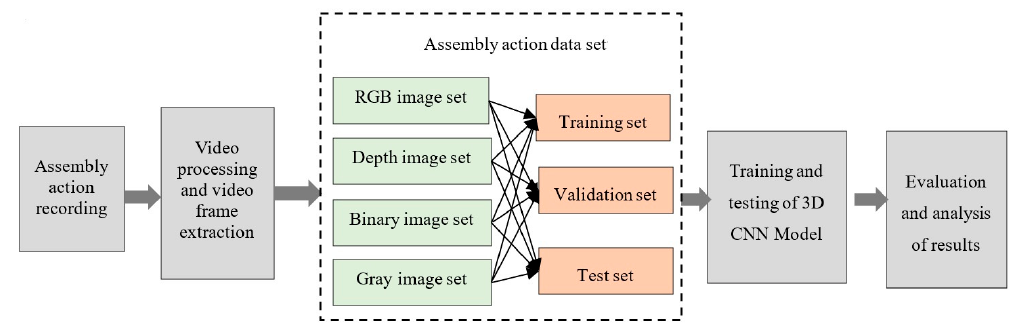
Figure 5. Flowchart for creating the data set for assembly action recognition.